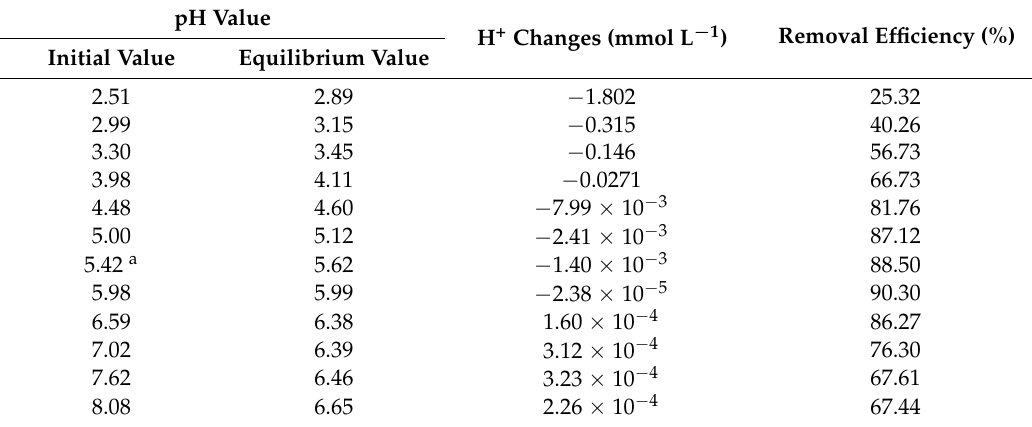
a actual pH value of the initial lead